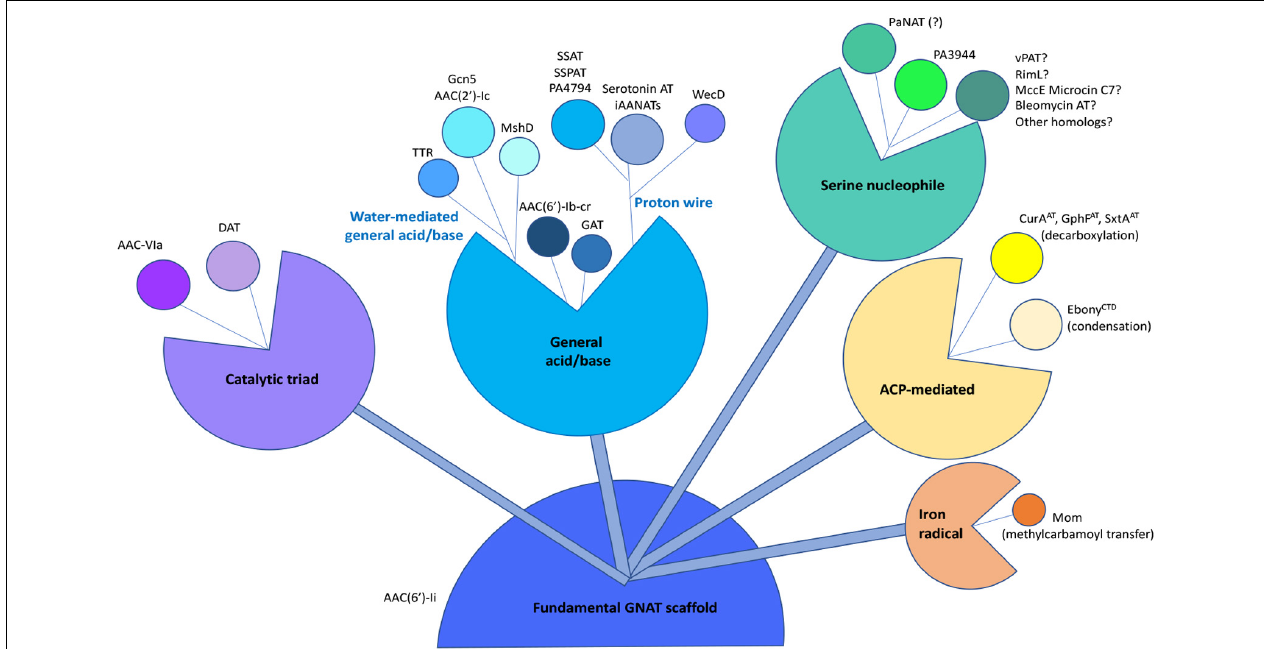
FIGURE 9 | Compilation of known chemical mechanisms of GNATs in the primary literature. All GNATs evolved from a common scaffold, which later gave rise to a variety of chemical mechanisms, including the general acid/base, proton wire (or remote general base or catalytic water), catalytic triad, serine nucleophile, acyl-carrier protein (ACP)-mediated, or iron radical-mediated. Examples of each type of chemical mechanism are indicated adjacent to each bud within the different sub-classes. The PA3944 enzyme from the current study is shown in bright green. Details of abbreviations and corresponding references for each example listed can be found in Supplementary Table S2